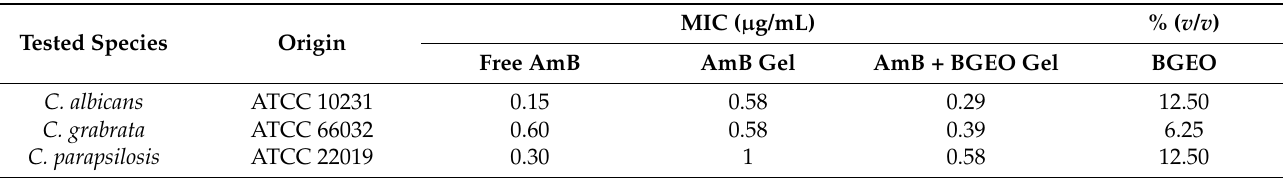
Table 4. MIC against different cultures of Candida spp., Free AmB, AmB gel, AmB+BGEO gel and B. graveolens essential oil (BGEO) after incubation at 30 °C for 48 h ( n = 3).